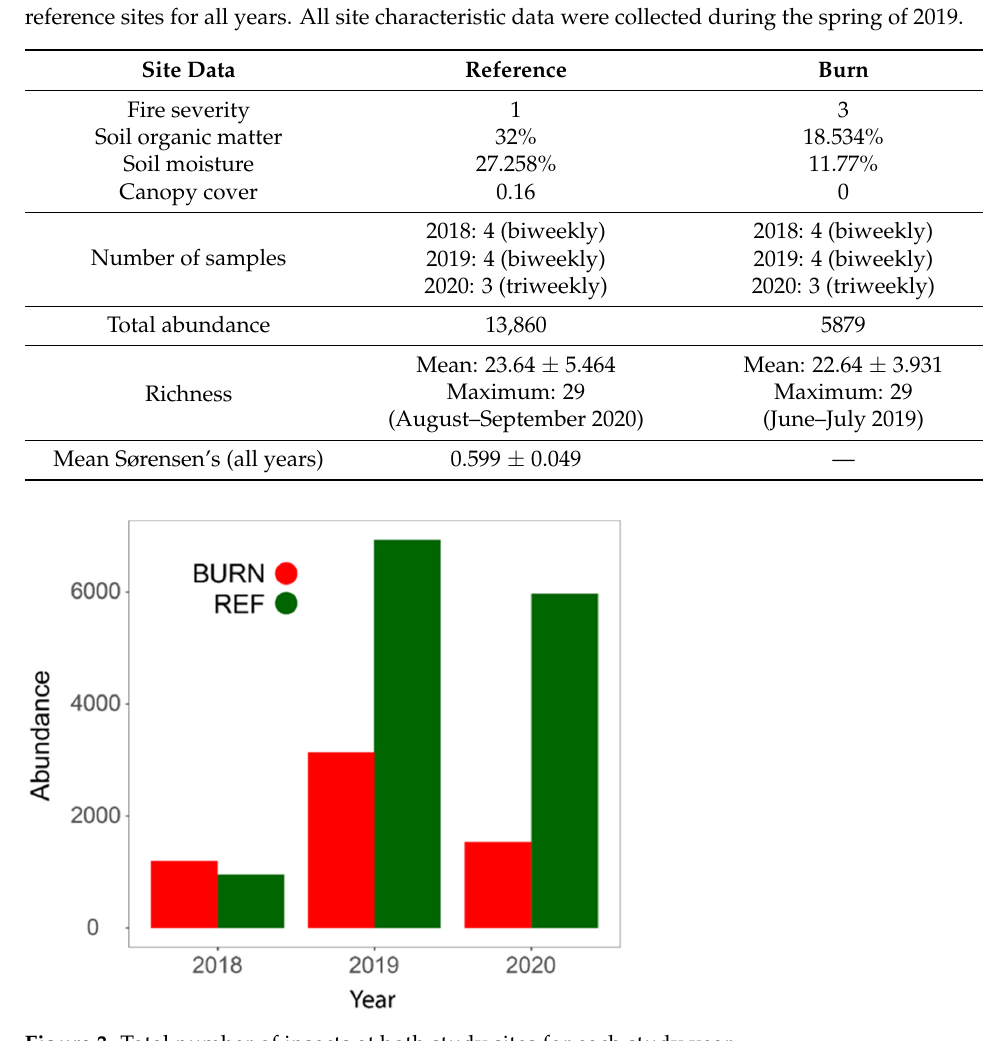
Figure 4. Mean Shannon–Wiener index values (transformed) for the reference site, burn site, and both sites, combined for each year. 3.2. Patterns in Insect Community Composition Sørensen’s similarity comparisons between sites, and within site samples (Figure 5), shows higher community similarity among reference site samples than among burn site samples in 2018 and 2019. In 2020, there was greater similarity across burn site samples than across reference site samples, indicating that the burn site community became more similar in composition from 2018–2020. Community similarity between burn and refer- ence sites was lower than either within the site sample comparison throughout the study period, indicating that the burn site diverged from the reference site quickly following wildfire and remained dissimilar, two years post-fire. The lower community similarity, when comparing between burn and reference sites, is a result of changes in abundance in several taxa, including many dipteran families in the burn site following the fire (see NMDS results, Figures 6–10).